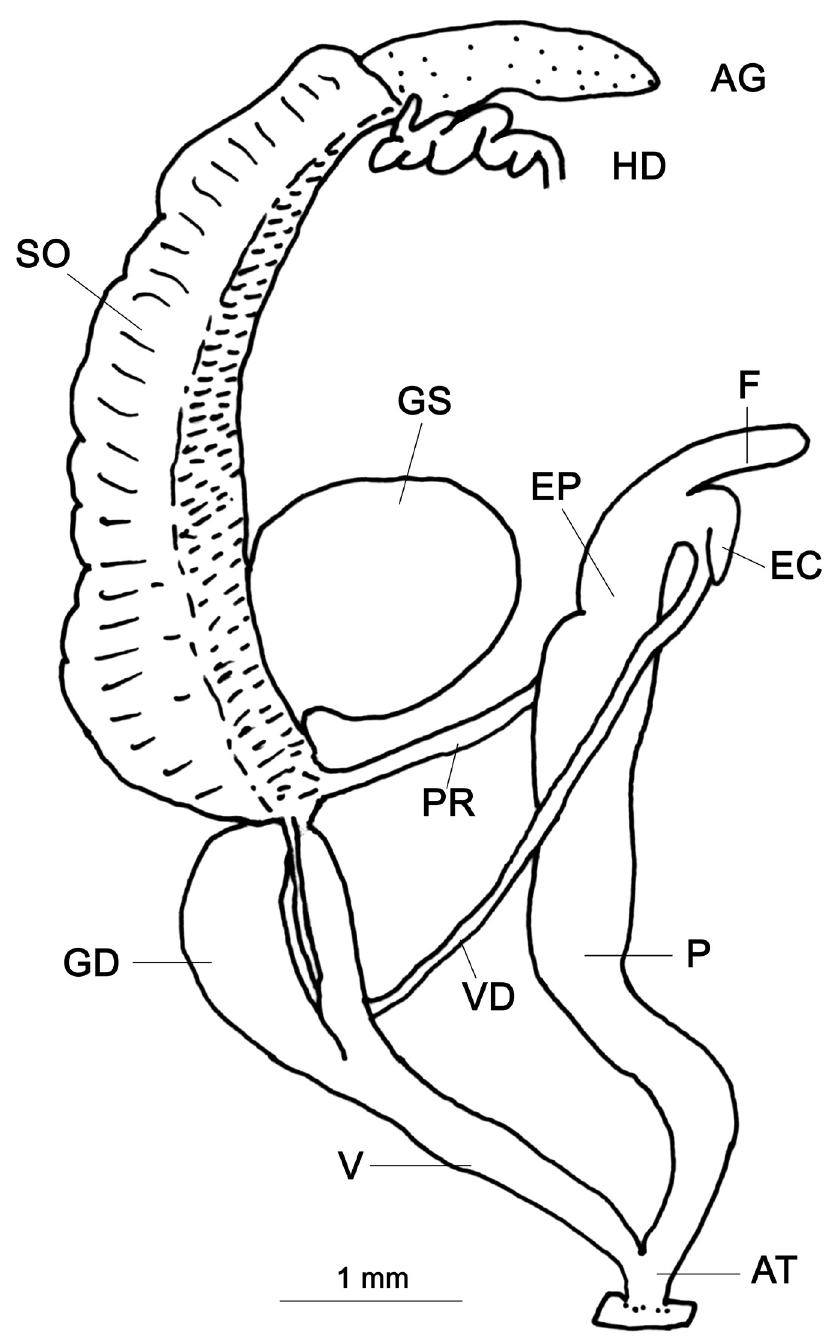
Figure 12. Genitalia of R. tribhuvana sp. n., holotype: CDZMTU077P, Tribhuvan University garden, Kirtipur, Kathmandu,